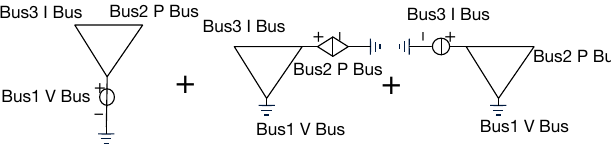
Figure 13. Superposition theorem for the simple power